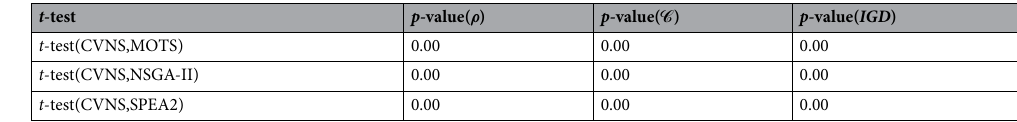
Table 6. Results of paired-sample t